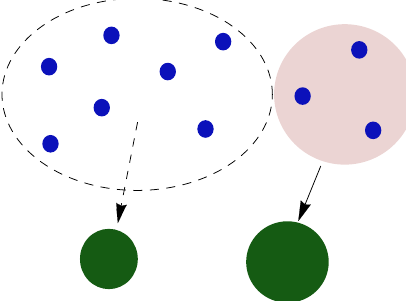
Figure 2. Same as Fig. 1 but with the known number of molecules (highlighted in pink) on the second